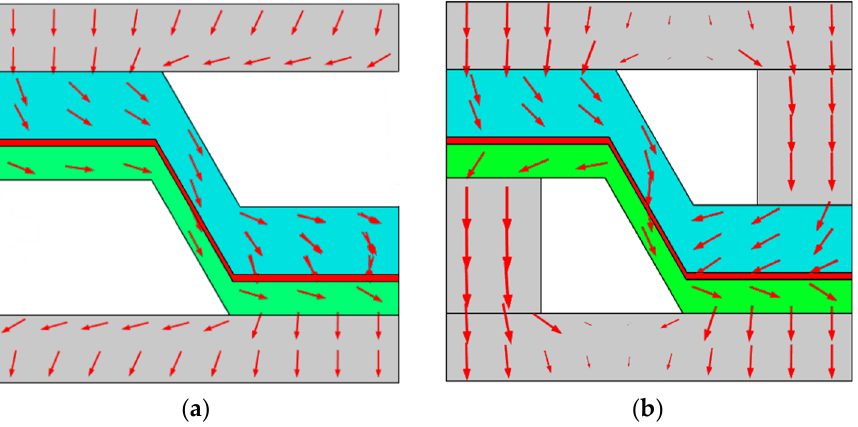
Figure 5 . Current path at cross-section: ( a ) conventional design; ( b ) vertical rib design.